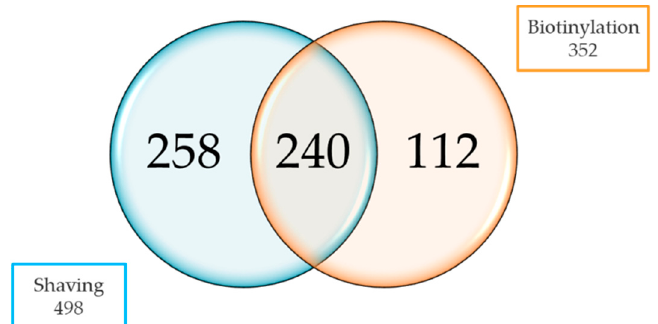
Figure 1. The number of identified proteins using surface proteomics. Venn diagram illustrating the numbers of identified proteins of the two complementary cell surface proteomics approaches, trypsin-shaving approach (blue) and biotinylation approach (orange).